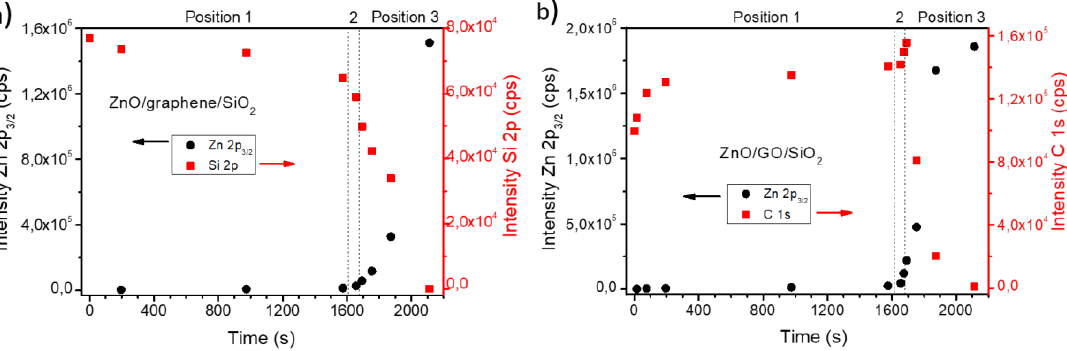
Figure 1. XPS intensities of the Zn 2p 3 / 2 (dots) and Si 2p / C 1s (squares) peaks versus evaporation time for the growth of: ( a ) ZnO / G / SiO 2 and ( b ) ZnO / GO / SiO 2 .